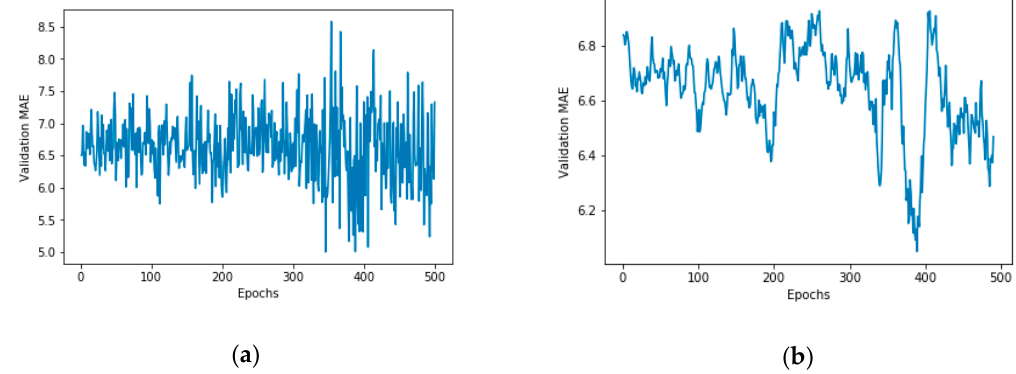
Figure 3. ( a ) Validation through MAE score for every training epoch; ( b ) Plot after smoothing.